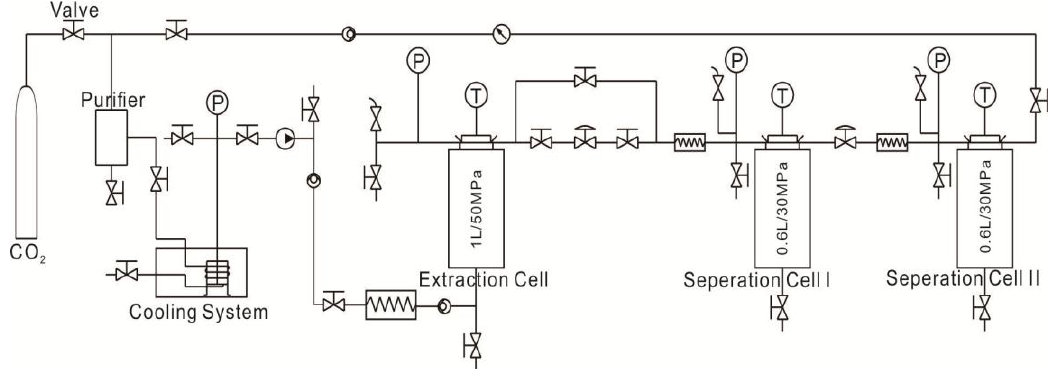
Figure 2. The flow chart of Sc-CO 2 extraction in this work.